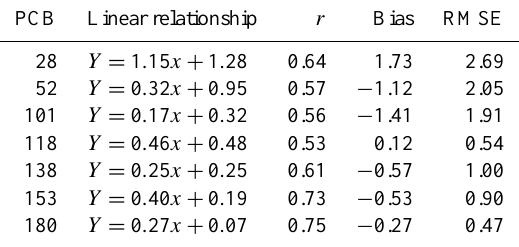
Table 3. Linear relationships and correlations between simulated and observed mean annual (2006–2010) concentrations for all NH non-urban locations (i.e., NUML + Arctic sites) with Pearson corre- lation coefficient ( r ) values, mean bias, and root mean square error (pgm − 3 ) . PCB Linear